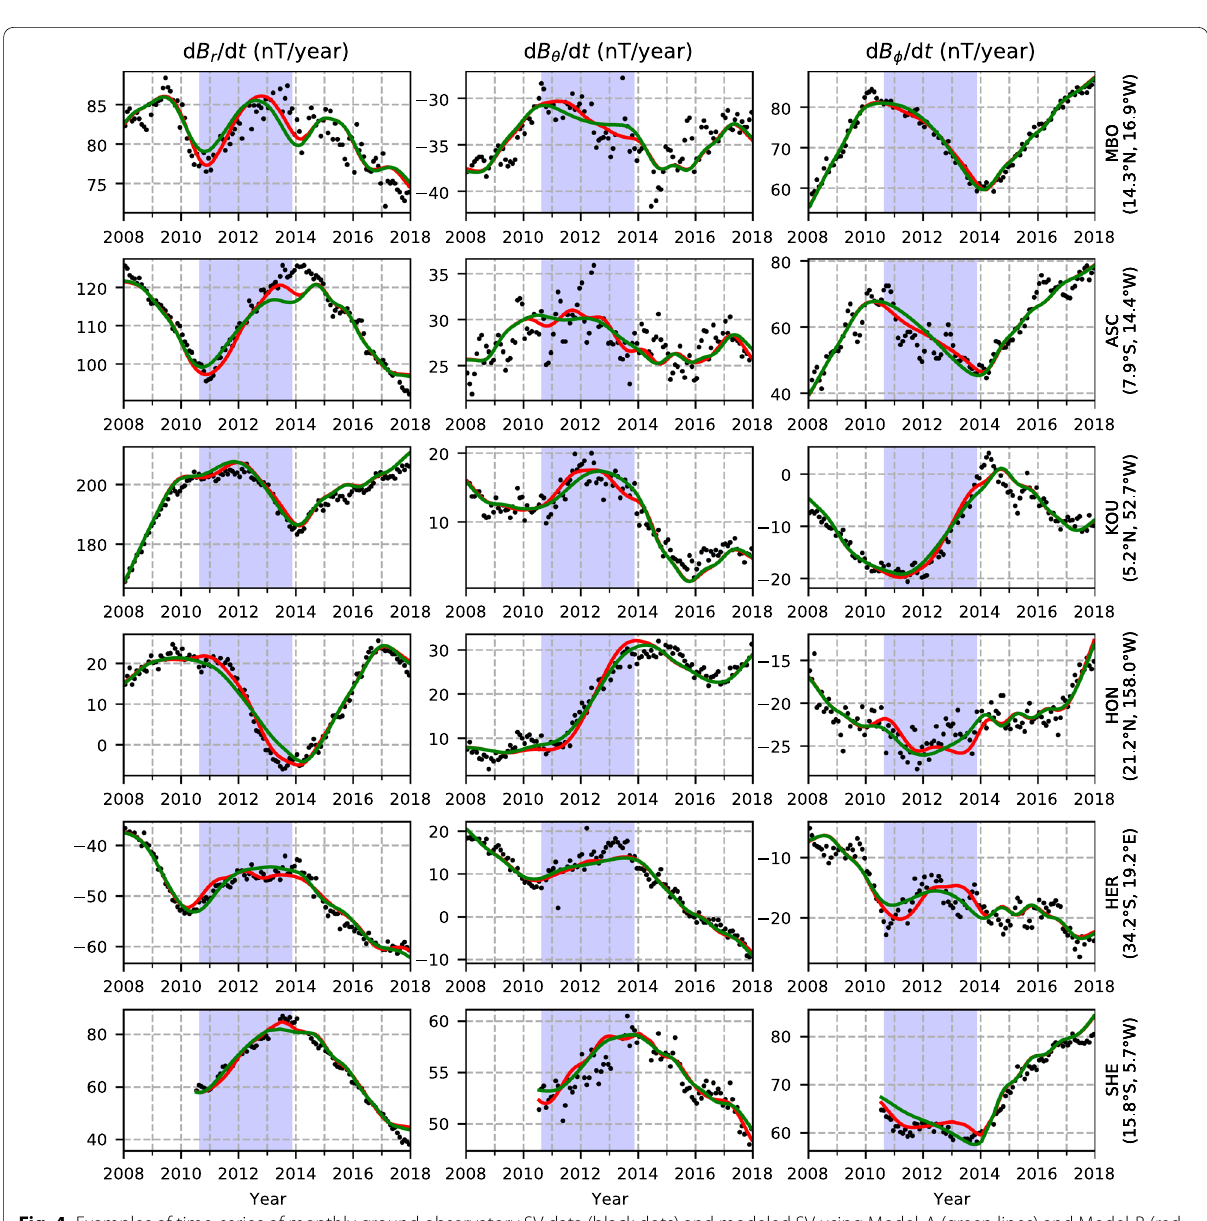
Fig. 4 Examples of time-series of monthly ground observatory SV data (black dots) and modeled SV using Model-A (green lines) and Model-B (red lines). The observatory names are MBour (MBO), Ascension (ASC), Kourou (KOU), Honolulu (HON), Hermanus (HER), and Saint Helena (SHE). The SV data of SHE are an independent dataset not used in the inversion. The gap period between CHAMP and Swarm is indicated as a blue-shaded region (Sep 2010–Nov